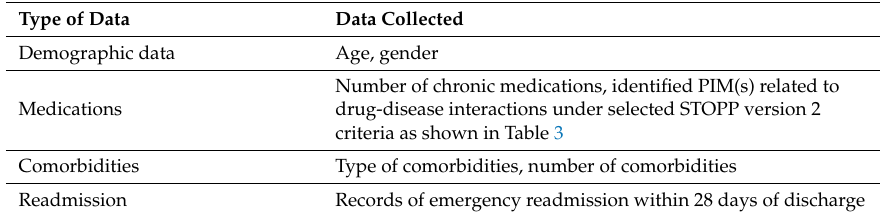
Table 2. Data collected from medical record